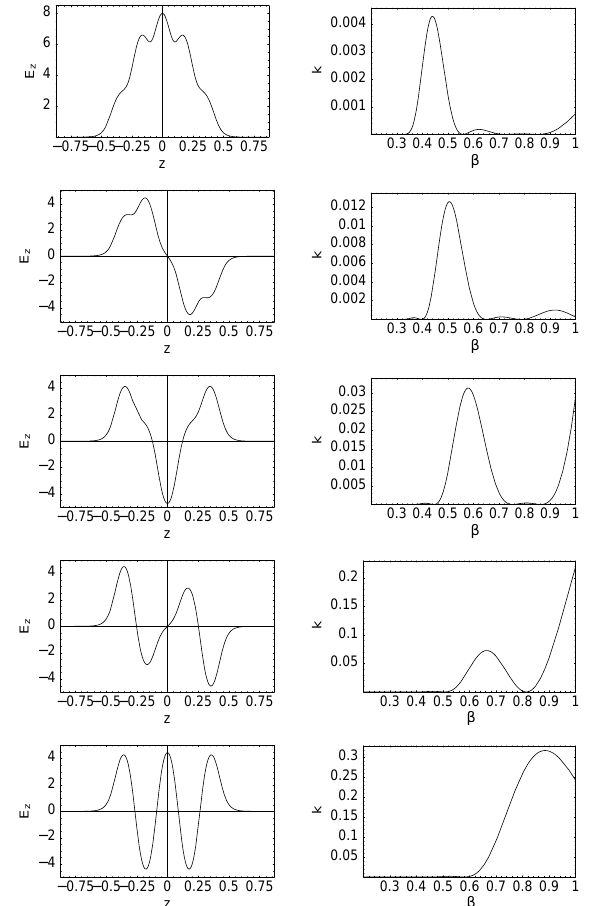
FIG. 5. Longitudinal component of the on axis electric field (arbitrary units) for the TM (cid:48)(cid:49)(cid:48) modes in the 5-cell APT b (cid:173) (cid:48)(cid:46)(cid:56)(cid:50) cavity versus (cid:122) (m) (left-hand column) and their loss factors (V (cid:121) pC) versus b (right-hand column).